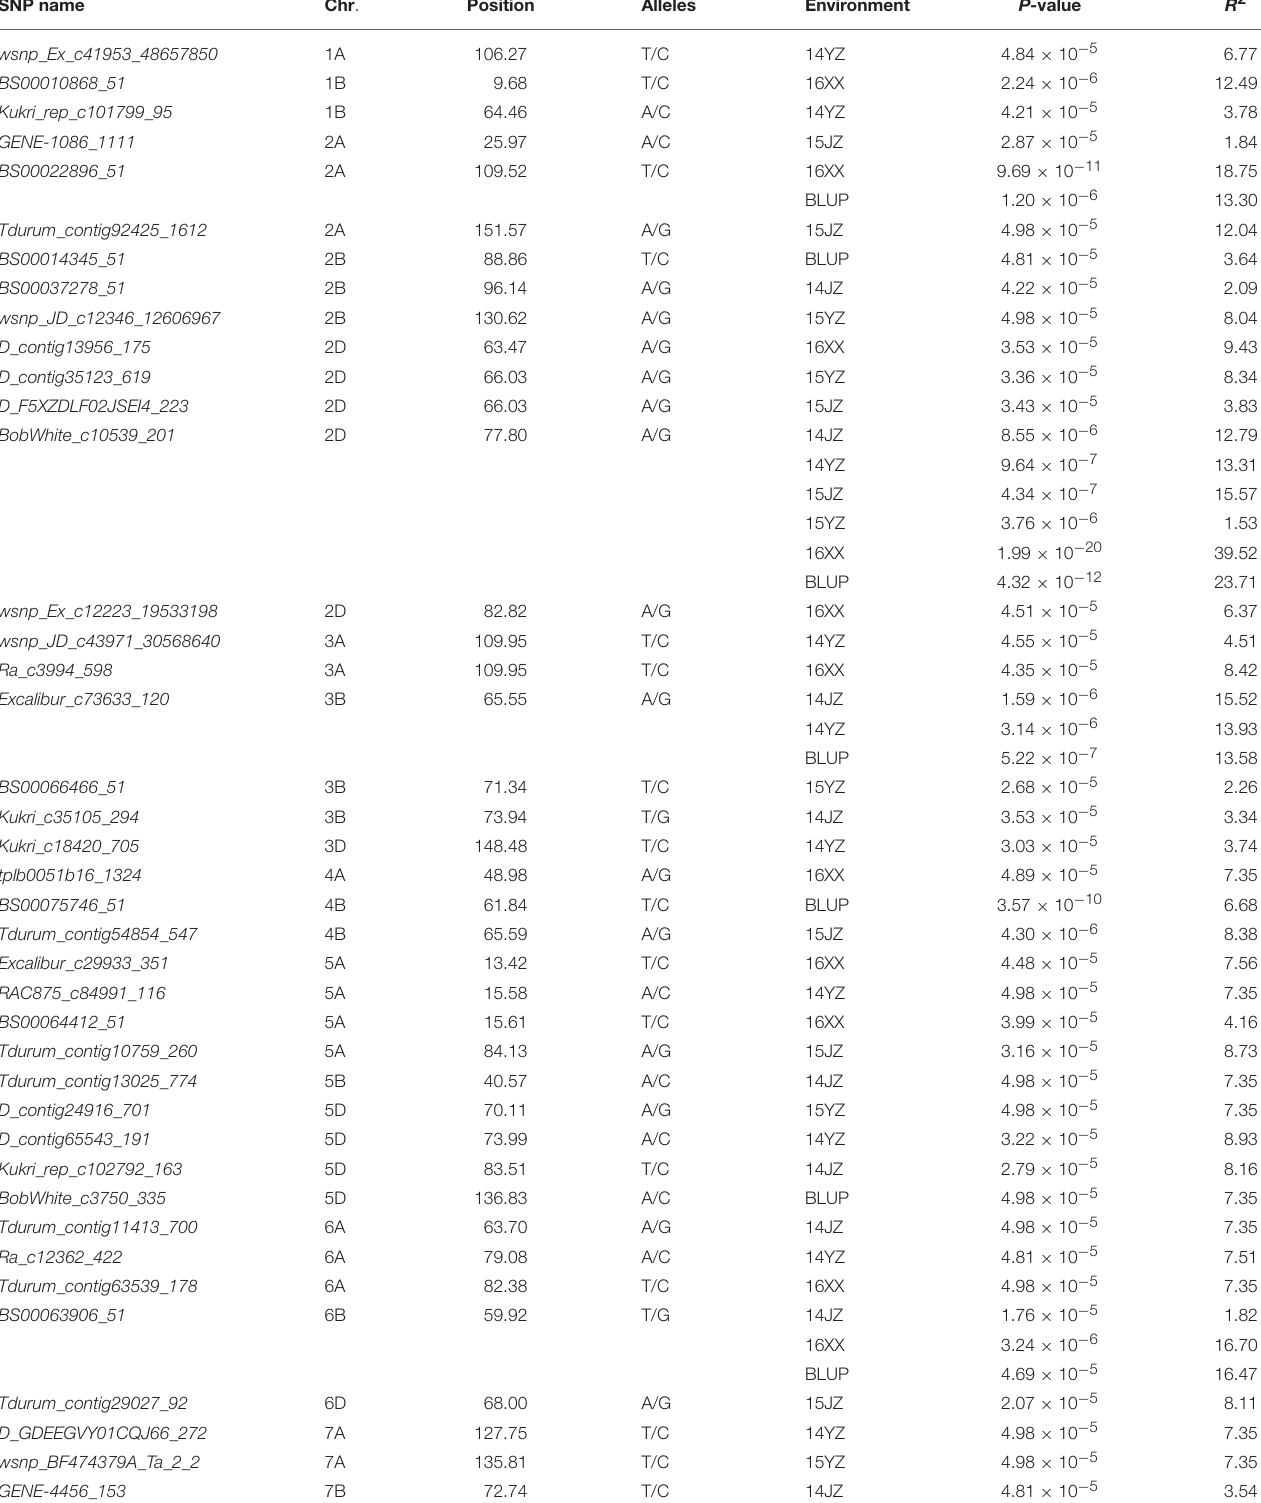
TABLE 2 | Sixty-two significant association signals (P < 4.99 × 10 − 5 ) involving 47 SNP